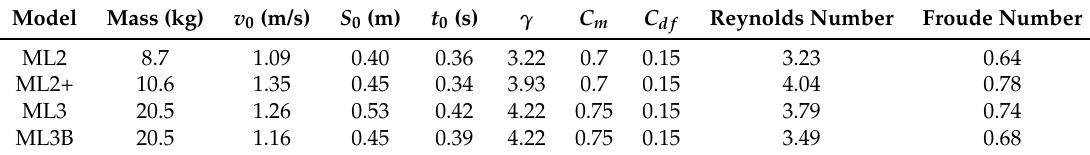
Table 3. Landslide models parameters for cases including a preceding uplift of 60 mm in 370 mm water depth.